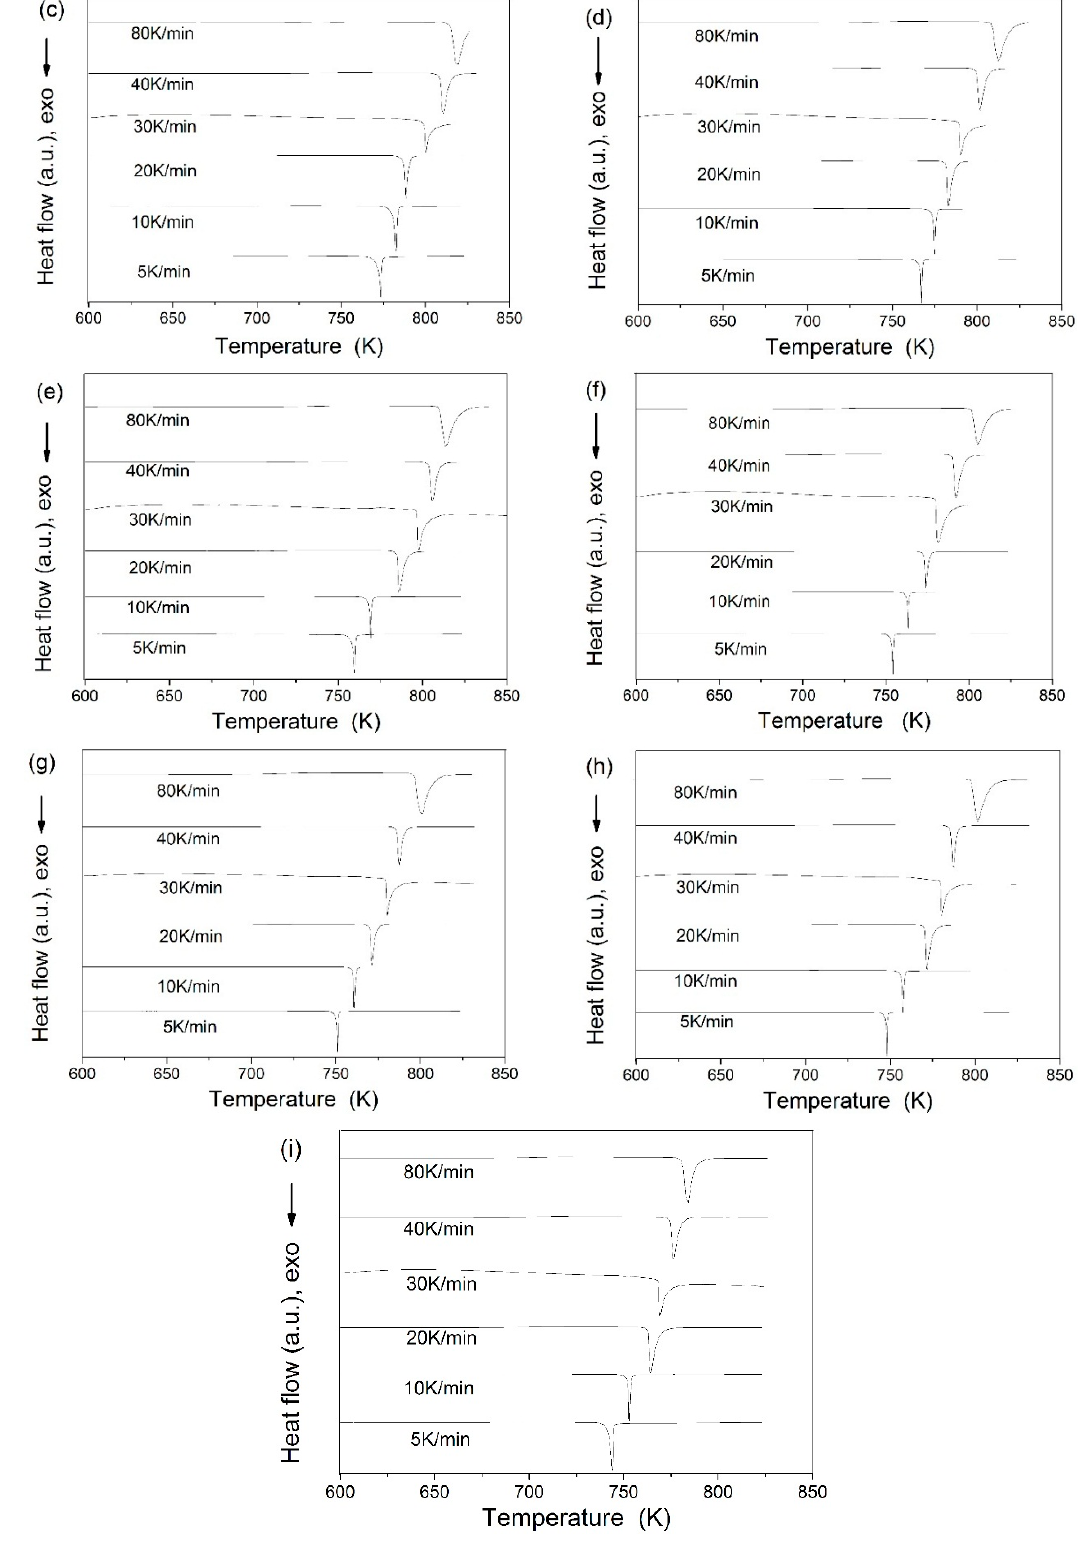
Figure 2. DSC curves for Φ 2 mm Zr-Al-Ni-Cu bulk metallic glasses at heating rates of 5–80 K ∙ min − 1 : ( a ) Zr 51 Al 14.2 Ni 15.9 Cu 18.9 BMG; ( b ) Zr 51.5 Al 13.6 Ni 14.9 Cu 20 BMG; ( c ) Zr 52 Al 12.9 Ni 13.8 Cu 21.3 BMG; ( d ) Zr 52.5 Al 12.2 Ni 12.6 Cu 22.7 BMG; ( e ) Zr 53 Al 11.6 Ni 11.7 Cu 23.7 BMG; ( f ) Zr 53.5 Al 10.9 Ni 10.6 Cu 25 BMG; ( g ) Zr 54 Al 10.2 Ni 9.4 Cu 26.4 BMG; ( h ) Zr 54.5 Al 9.6 Ni 8.4 Cu 27.5 BMG and ( i ) Zr 55 Al 8.9 Ni 7.3 Cu 28.8 BMG.